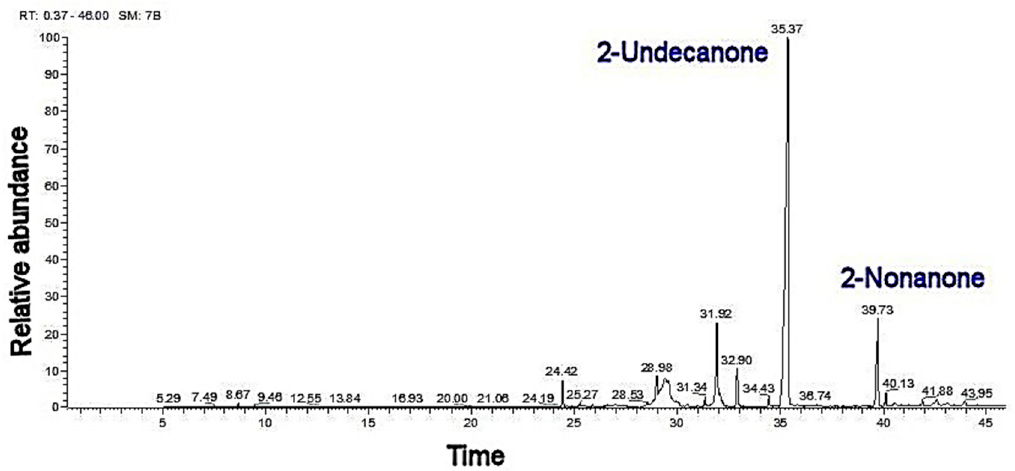
Figure 3. Showing the GC-MS of R. graveolens .